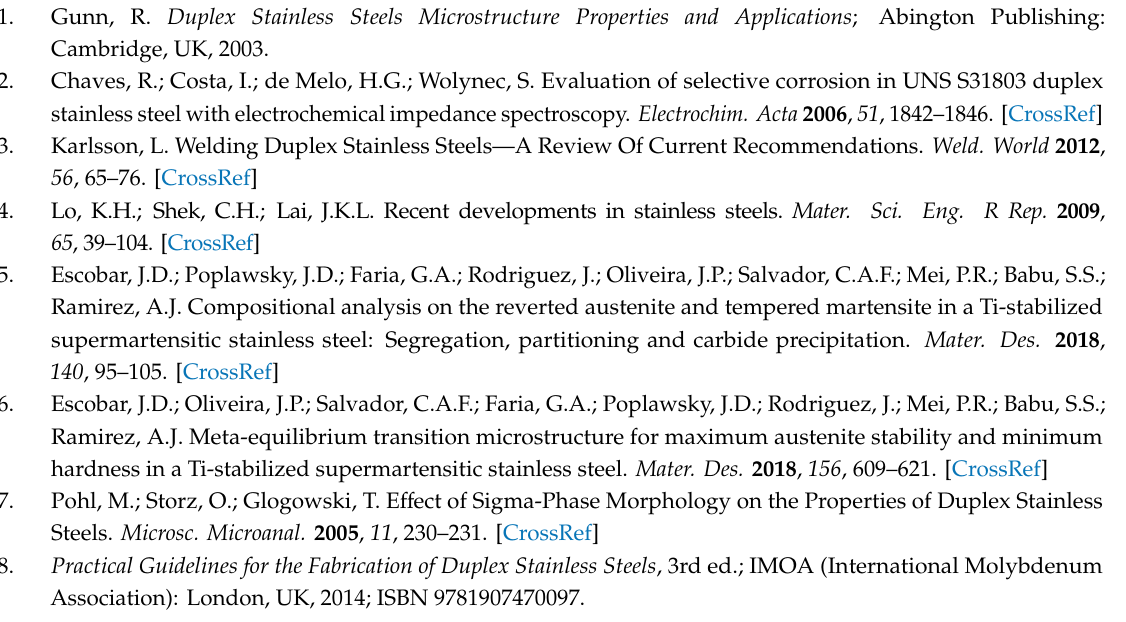
Figure S1: 2D and 3D surface profiles of the specimens (0–180 min,